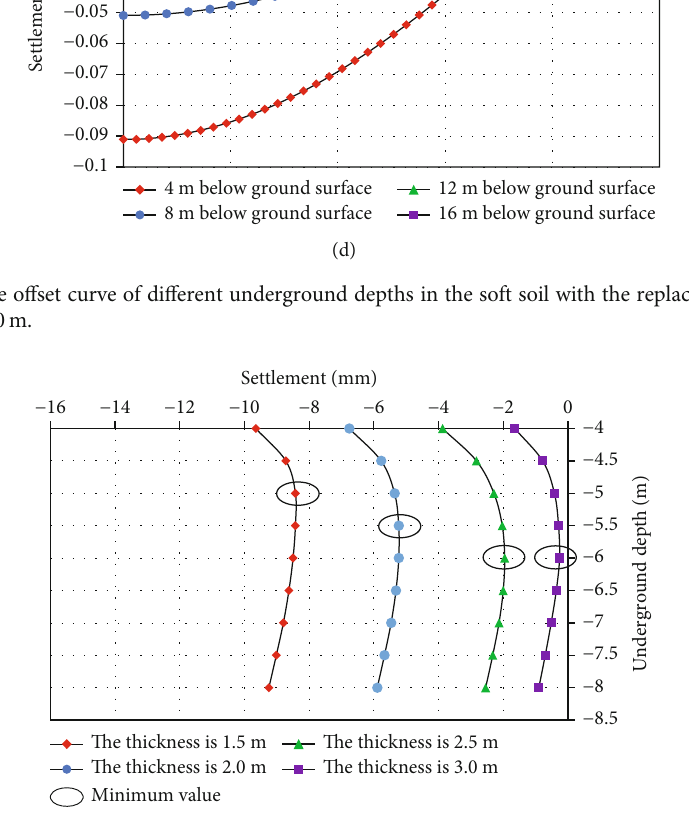
Figure 6: Settlements in the soft foundation of di ff erent underground depths under slope